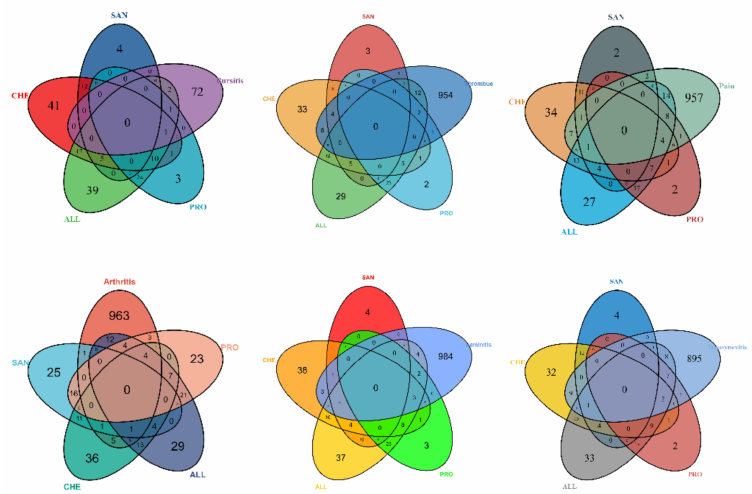
Figure 5. Venn diagram of target genes between compounds and hoof disease-related